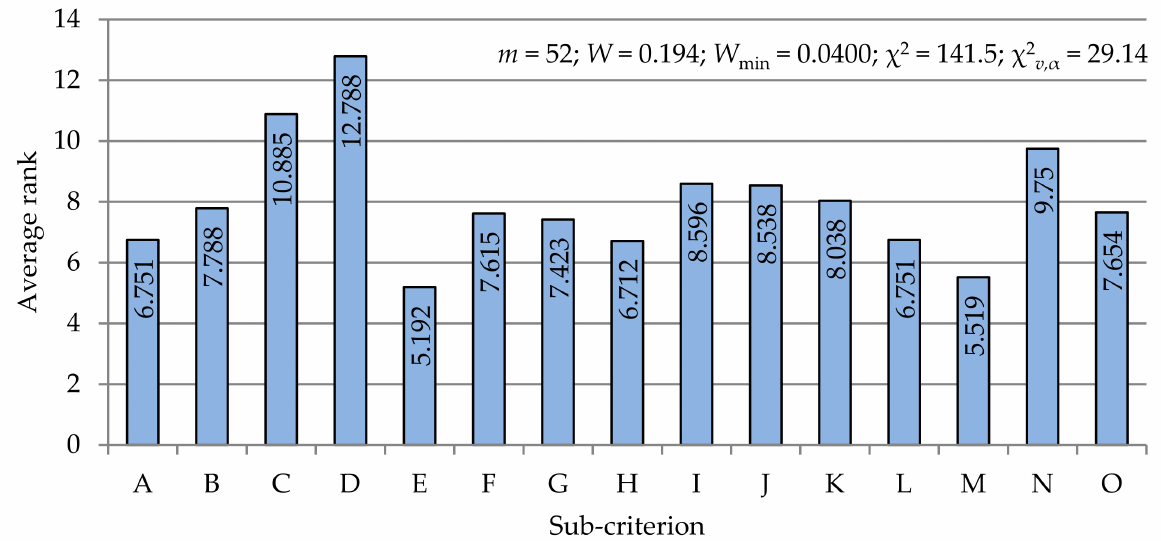
Figure 3. The average ranks of sub-criteria R j .